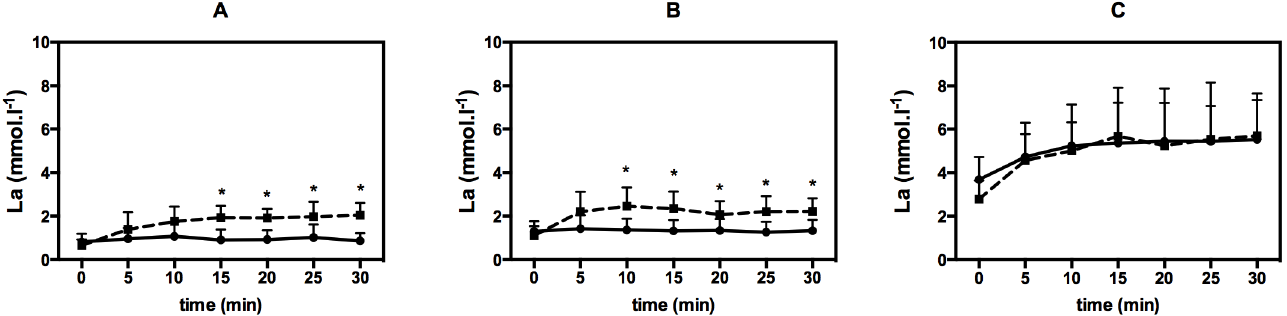
Fig 4. Comparison of blood lactate response (La) during high-intensity interval exercise (dotted line) vs. continuous exercise (full line) for mean exercise intensities A, B, and C. Values are given as mean and SD. “ * ” represents significance.